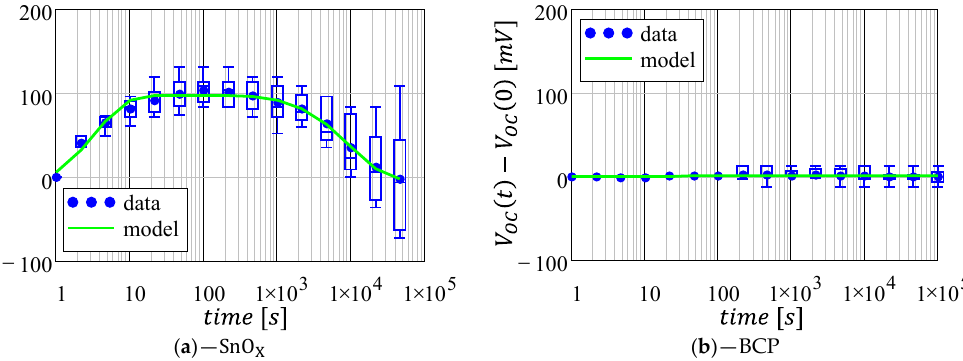
Figure 4. Normalized open-circuit voltage as a function of time for the two architectures under analysis: ( a ) SnO X -based cells; ( b ) BCP-based cells. Data fitting (green line) was computed using the mean values (blue circles) as a data-set. Plots are reported with the same axis for a direct comparison. Full-scale axes are reported in Supplementary Figure S3.